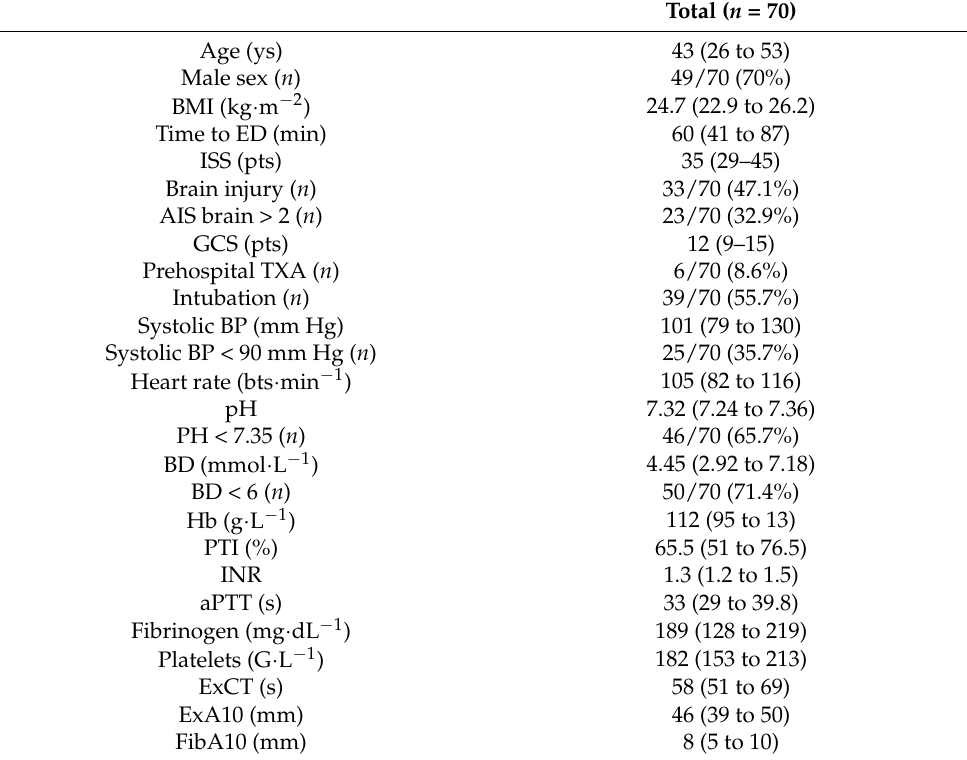
Table 1. Patient’s characteristics and laboratory measurements at admission to emergency depart- ment. Values are median (IQR) or numbers